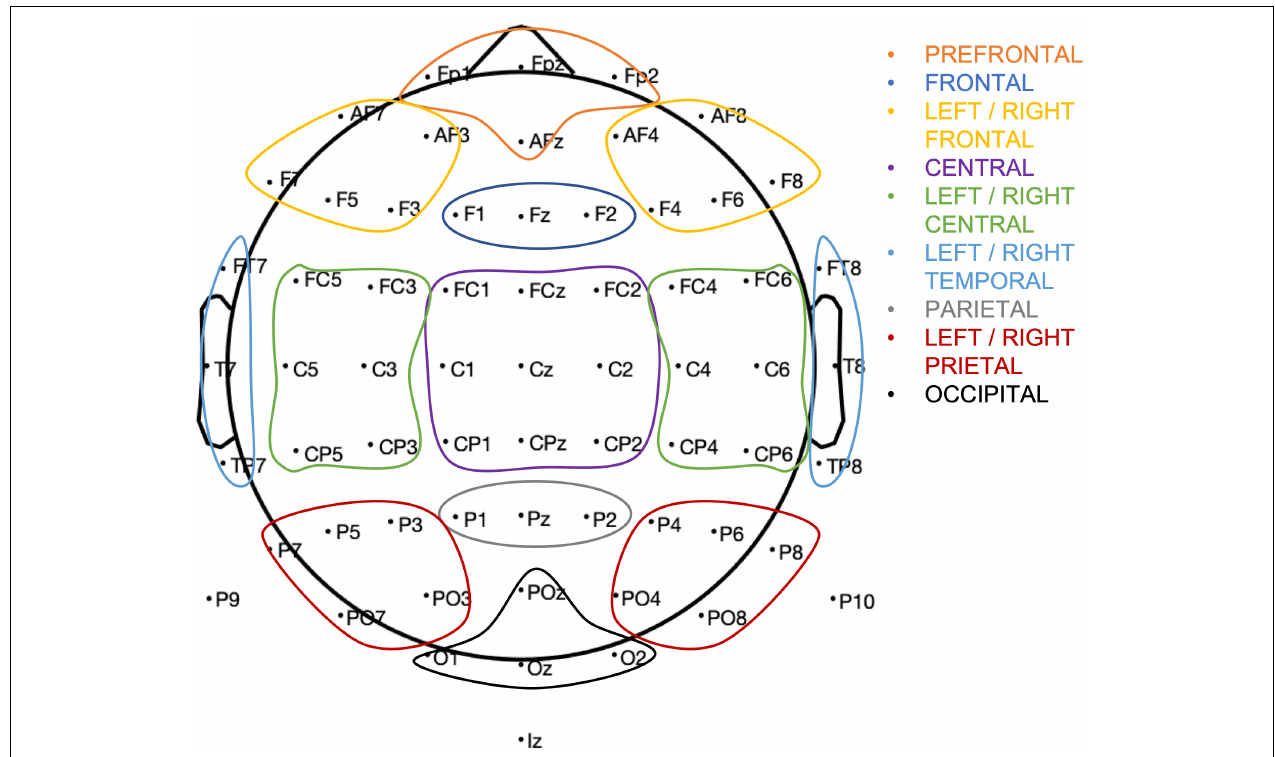
FIGURE 3 | Region of interest and corresponding electrode assignment.